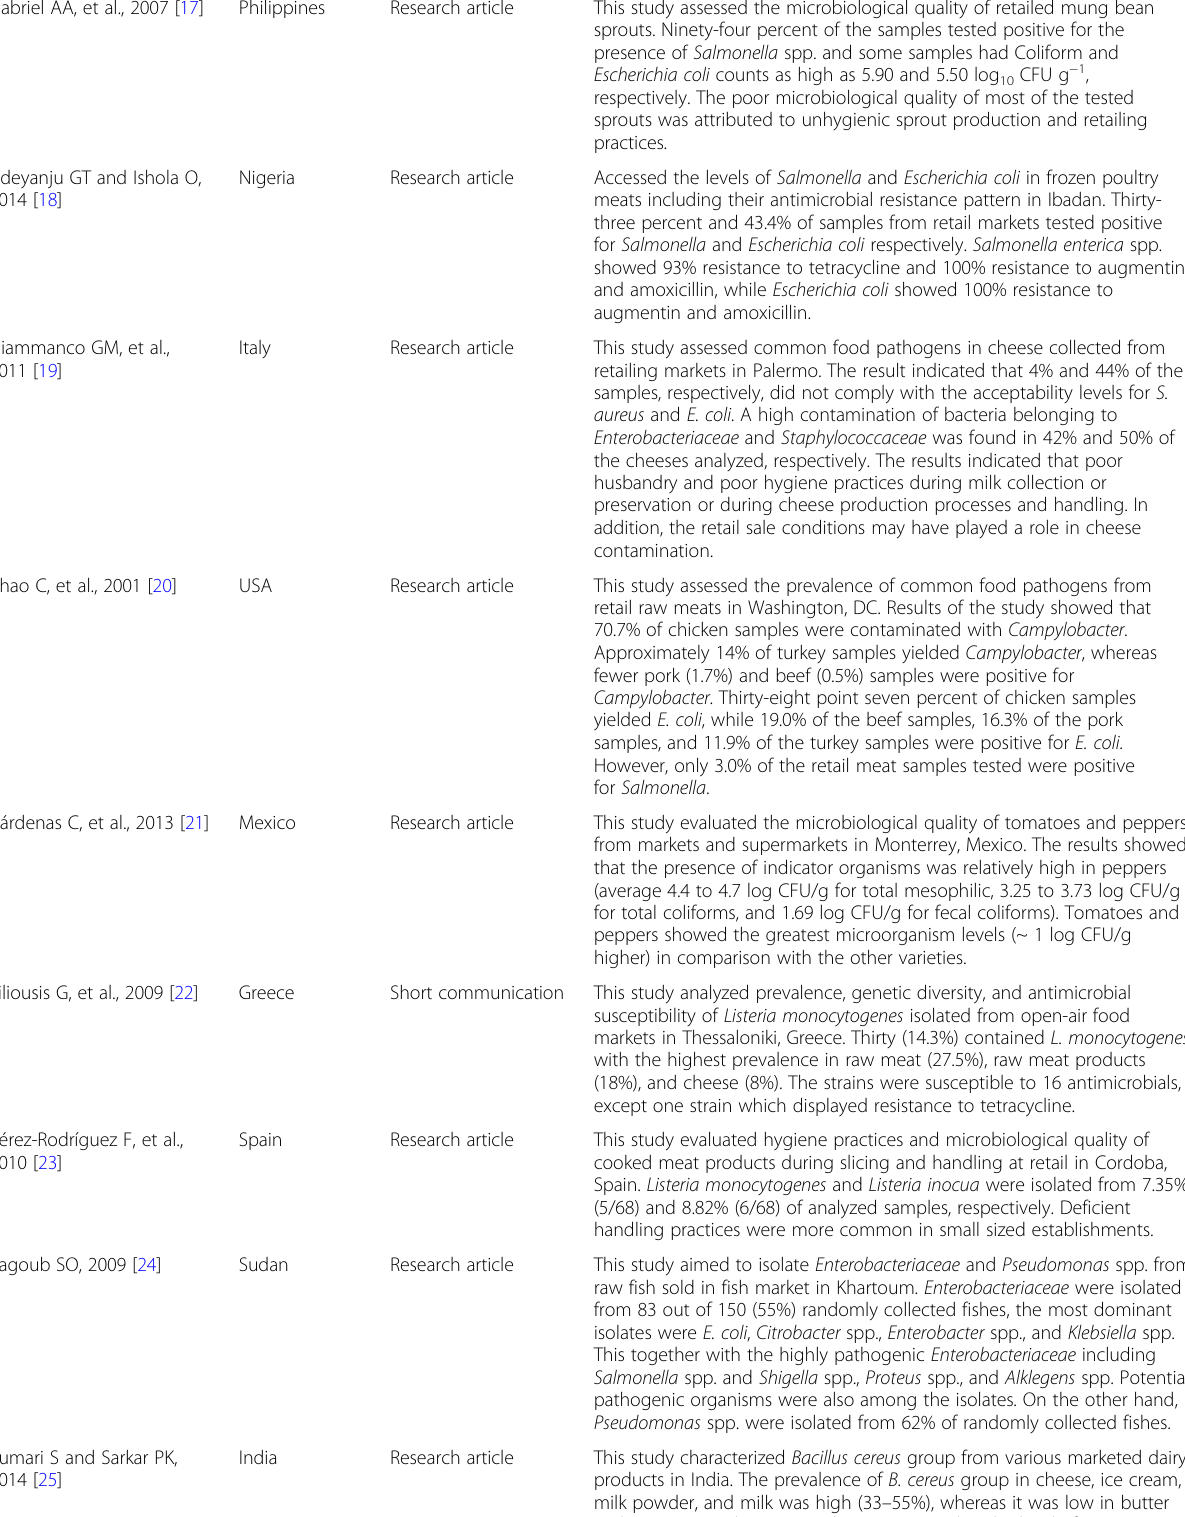
Table 3 Summary of full-text articles which reported microbial contamination of foods as a public risk in food